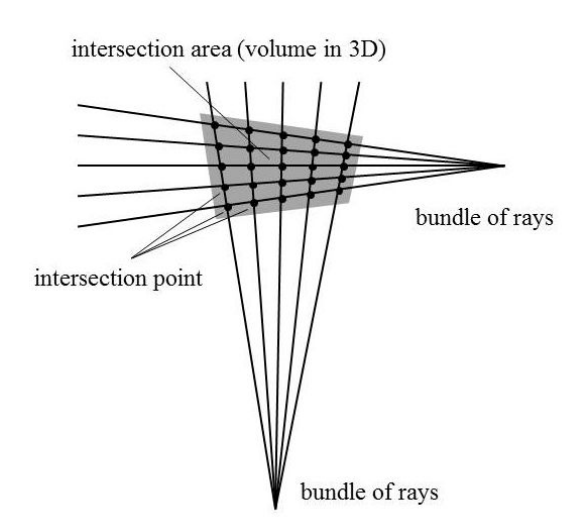
Figure 9. 2D-representation of the grid ray intersection method In 3D, the rays will not intersect because they will be skew lines. This is true for any two lines from different bundles but some lines will pass each other at a close distance such that they can count as intersecting. It is necessary to identify these